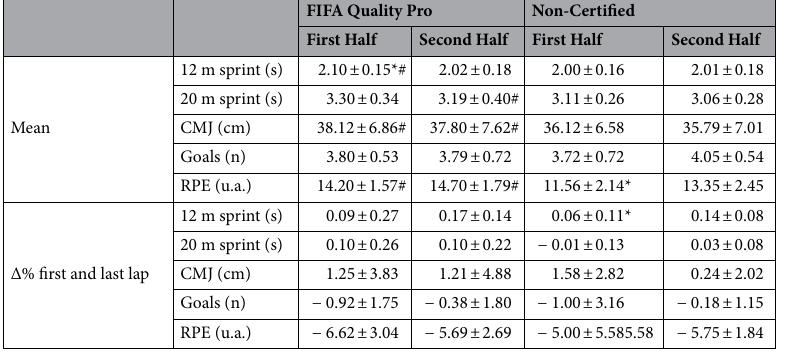
Table 2. Physical demands and RPE scale during the first and second half of BEAST 90 in a FIFA Quality Pro and non-certified artificial turf football fields. *Differences between 1st half and 2nd half; # Differences between FIFA Quality Pro and non-certified.